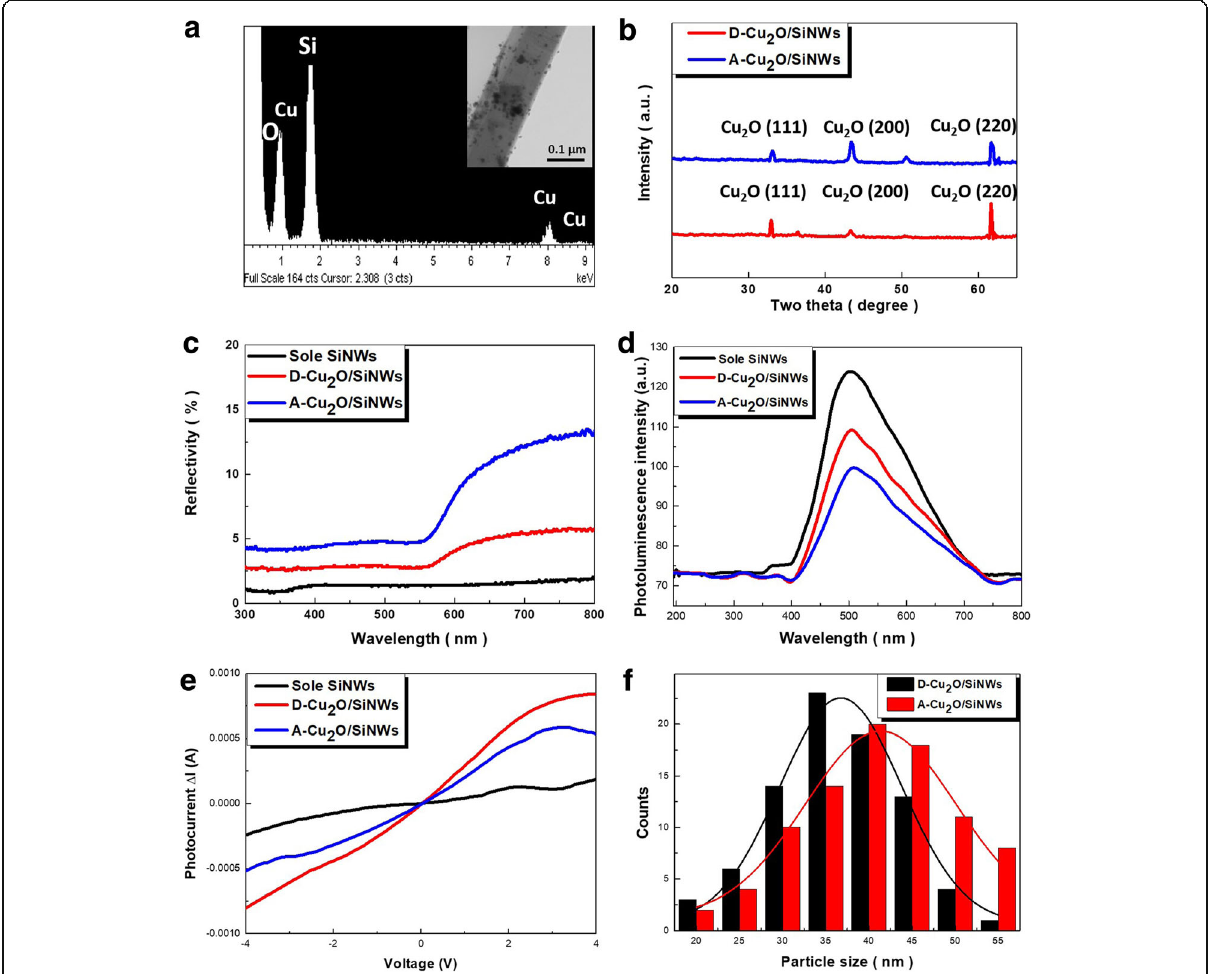
Fig. 2 a EDS spectrum of dispersed Cu 2 O/SiNW arrays. The insert figure was the corresponding TEM image. b XRD analysis, c light reflectivity and d photoluminescent results, e photocurrent enhancement ( I photocurrent − I dark current ) and f size distributions of the